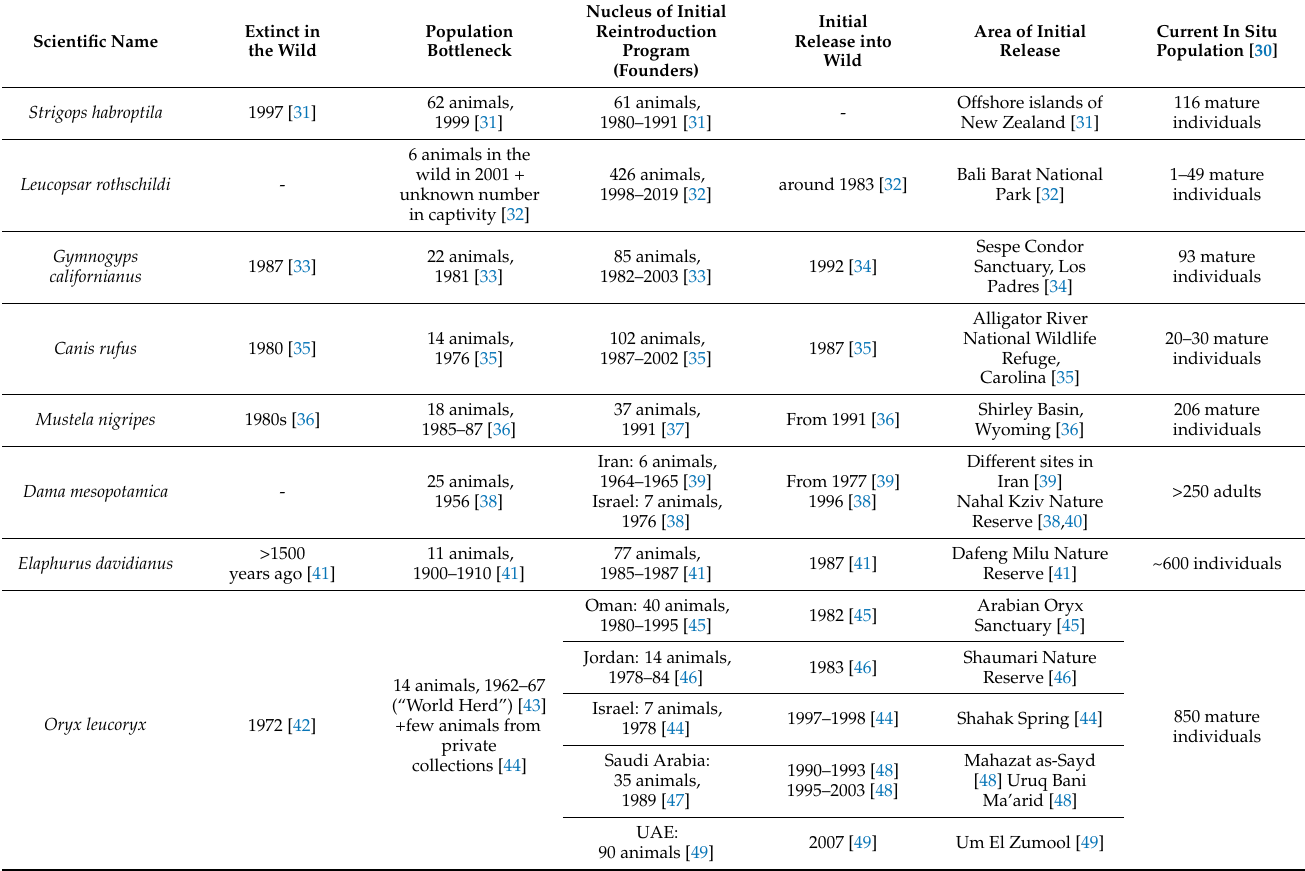
Table 1. Overview of selected bird and mammal species that were at the brink of extinction owing to human exploitation, populations were reduced to very few individuals that formed the basis for (more or less successful) reintroduction or translocation programs. These examples can be useful to adopt a more symmetrical view on HWC, while also illustrating global relevancy of the underlying phenomenon (resource-overexploitation by humans) and global applicability of mitigation strategies (reintroduction and translocation). Superscript digits refer to